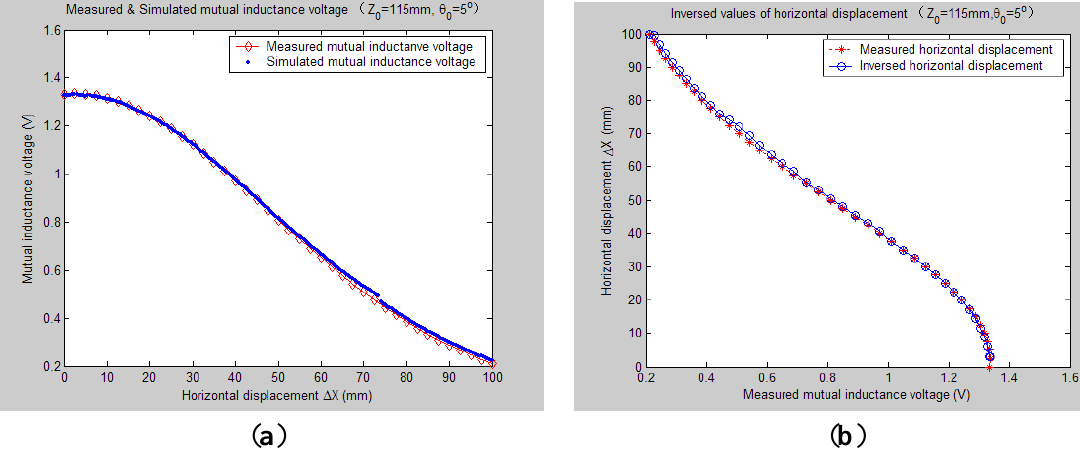
Figure 8. Inversed horizontal displacement of H-type sensor ( θ